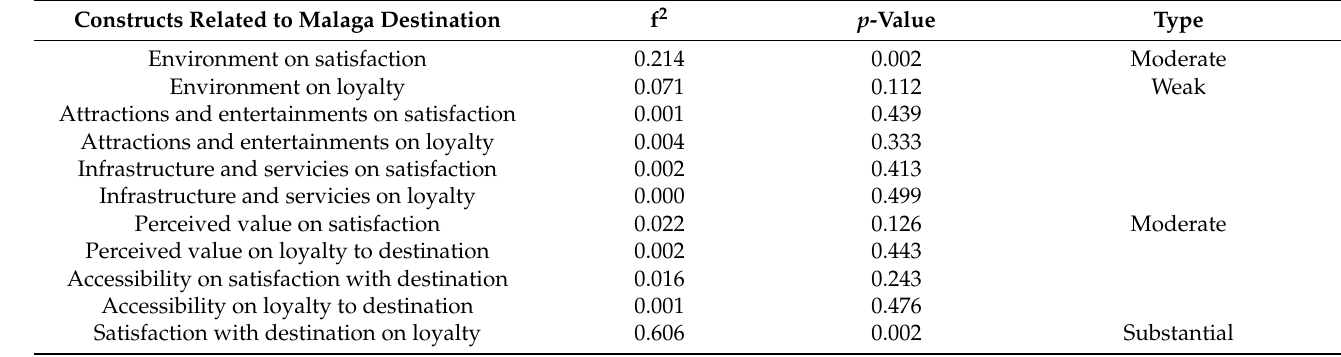
Table A2. Effect size f 2